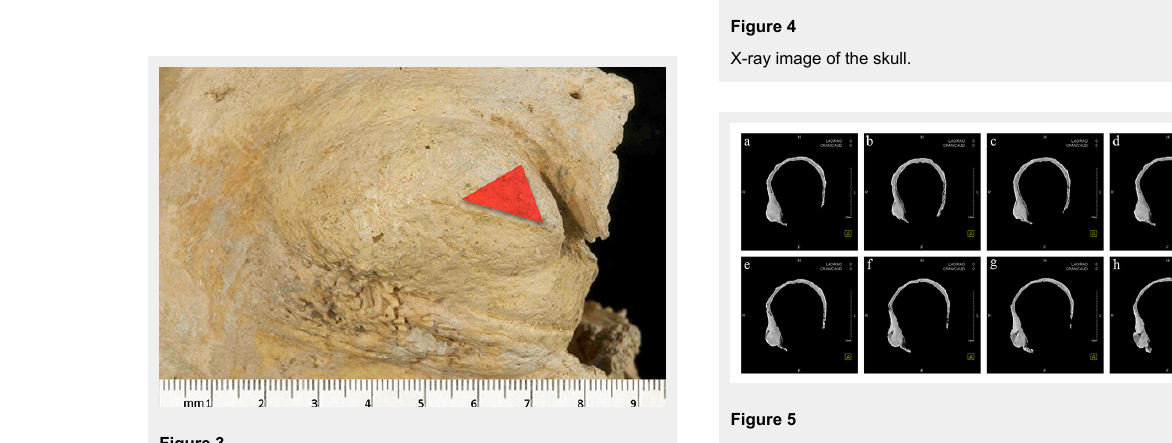
Horizontal computed tomography cross-sections of the skull. Selected representative